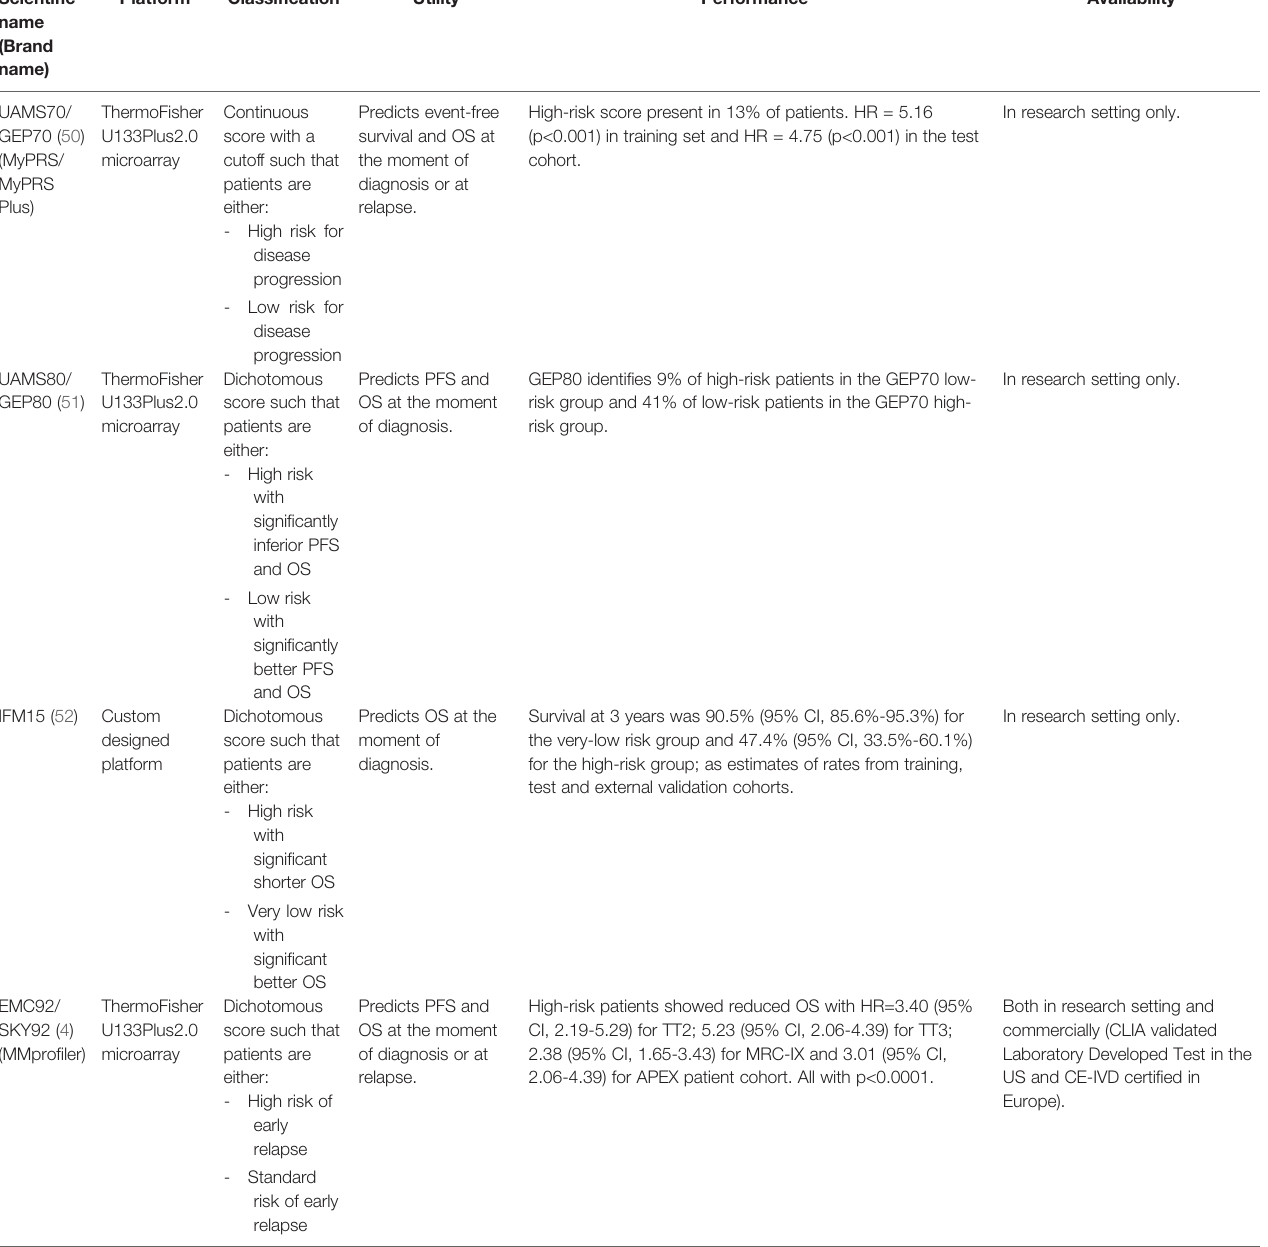
TABLE 1 | GEP risk signatures and their